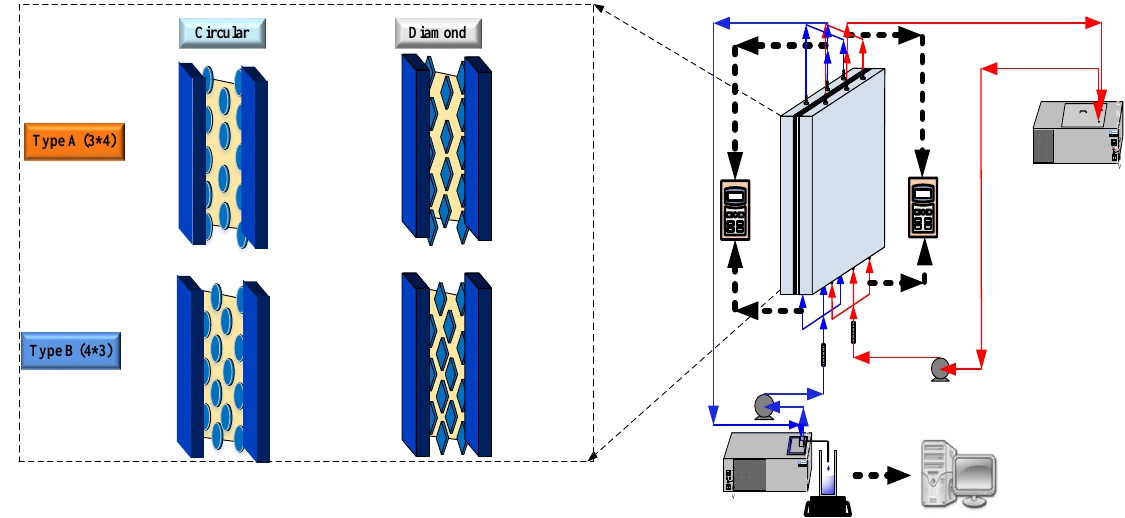
Figure 1. Schematic diagram of the experimental setup for the direct contact membrane distillation (DCMD) system.